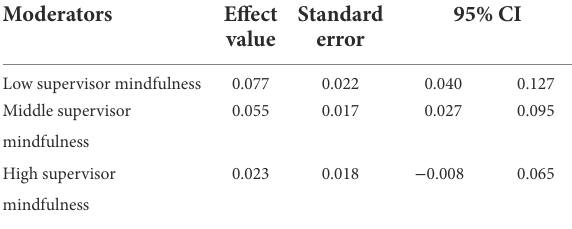
TABLE 5 Results of the moderated mediation effect